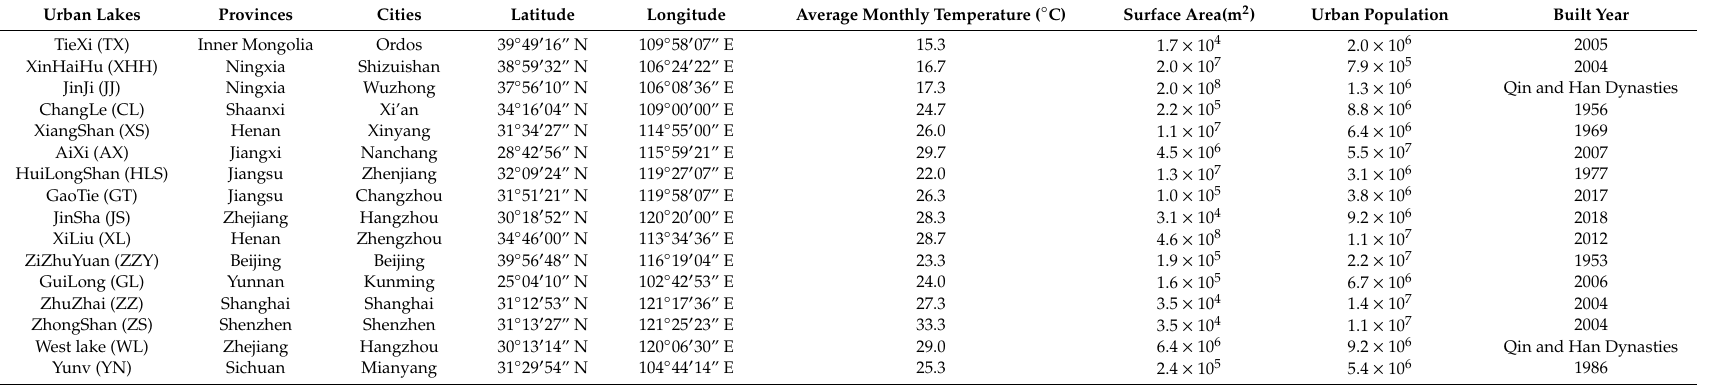
Table 1. The 16 urban lakes located in di ff erent areas of